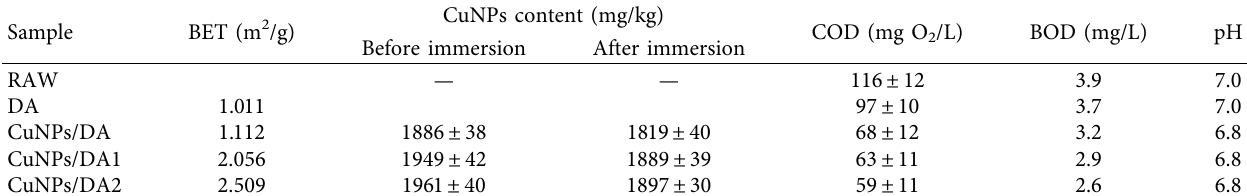
Table 1: COD and BOD parameters in fshpond water samples were treated by CuNPs/DA. Sample BET (m 2